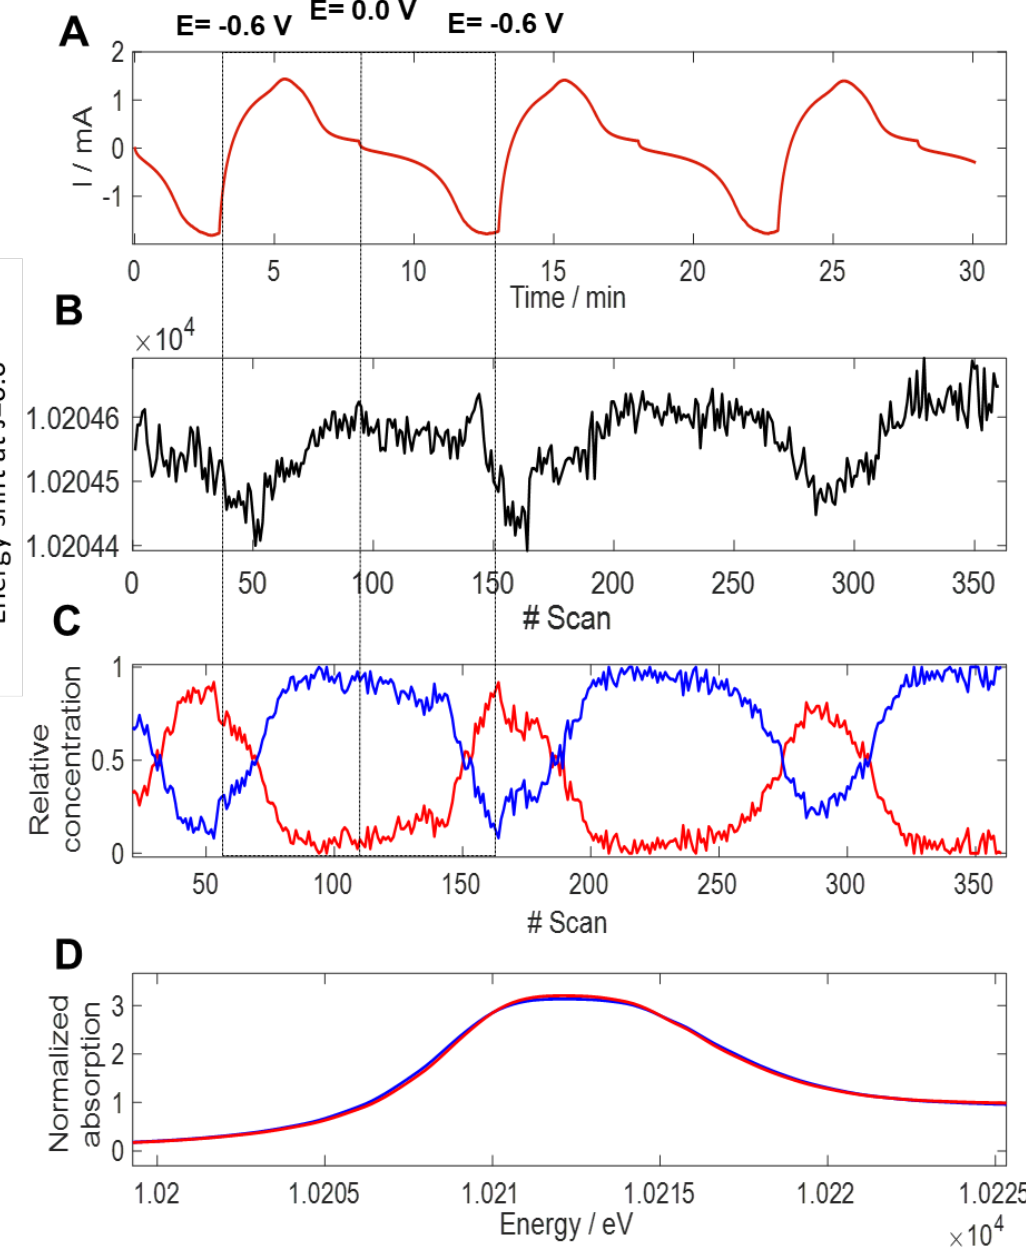
Figure 7. ( A ) Current vs. time curves for Li HTB. ( B ) Energy shift obtained at J = 0.6 as a function of the spectra number. The dotted lines indicate the values where the potential reaches −0 .6 V and goes back to 0.0 V vs. Ag/AgCl. ( C ) Concentration profile of the two principal components required to describe the operando XAS spectra (blue and red). ( D ) Reconstructed XANES spectra of the two independent components required to describe the Li HTB system.